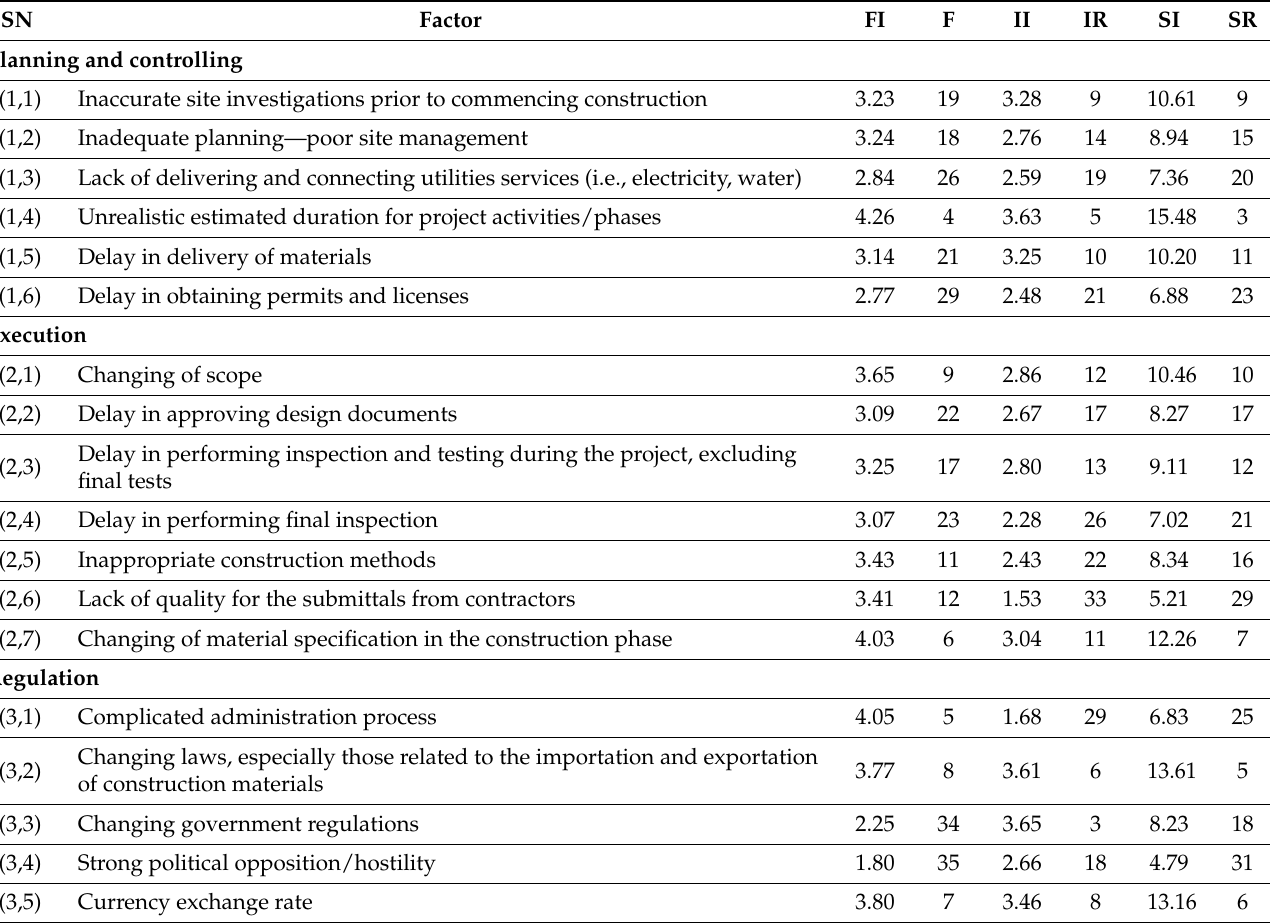
Table 2. Ranked significance of the selected risk